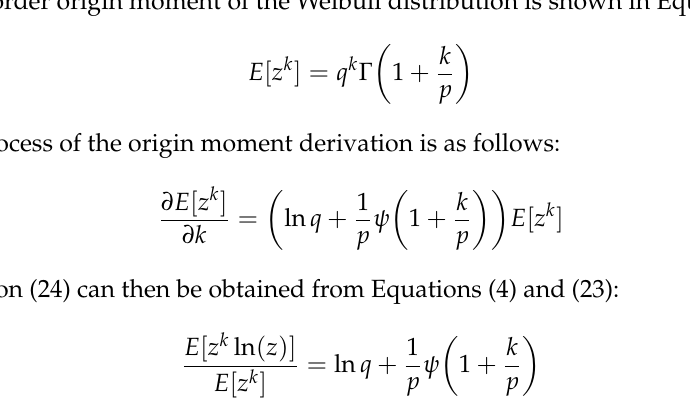
Table 7. The calculation time in simulated log–normal distribution ( k = 0.5).